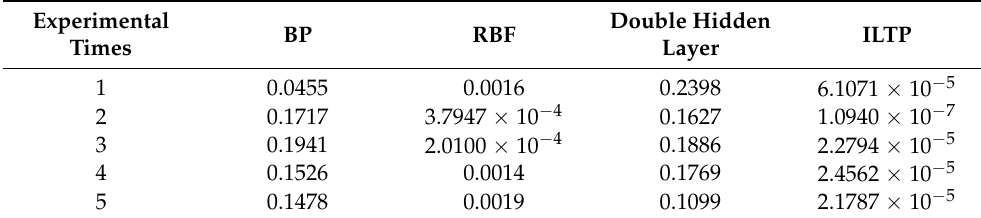
Table 2. Comparison results of average absolute error.